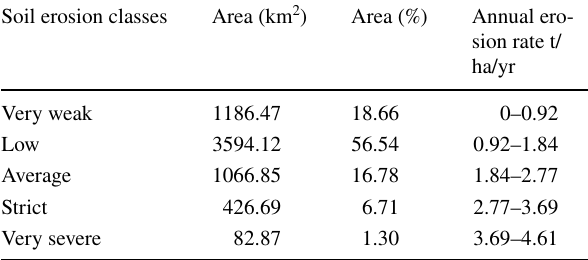
Table 12 Classes of areas vulnerable to erosion Soil erosion